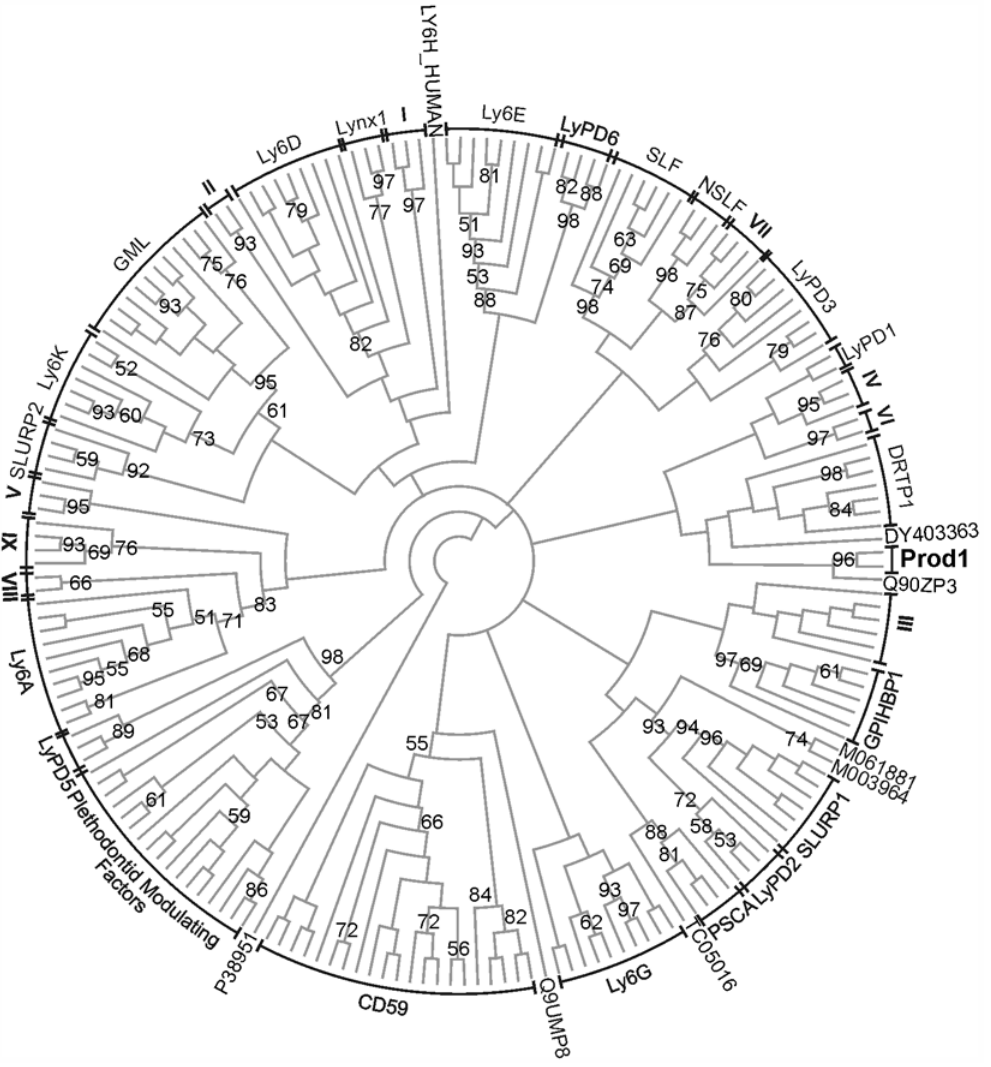
Figure 4. Majority-rule consensus phylogenetic tree of representative sequences of single-domain TFPs computed by maximum- likelihood using PhyML. Numbers refer to bootstrap confidence values; only those greater than 50% are shown. The sequence of the TFP domain of the Type II activin receptor was used to root the tree, but was removed from the figure. See Table S2 for the identity of the sequences in each grouping.